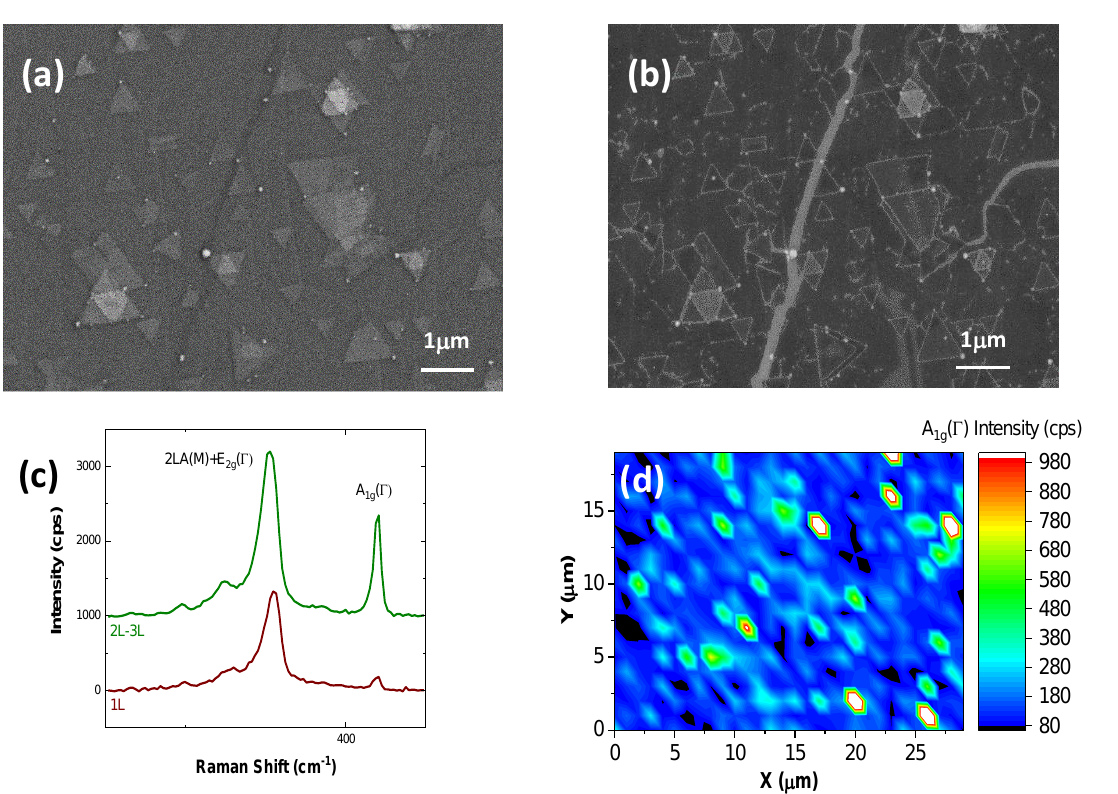
Figure 1. SEM (5 keV) image of a sample made of a WS 2 layer CVD-grown on epiGr/SiC, taken after 2 days of exposure to the ambient environment. ( a ) Image obtained from the SE2 detector; ( b ) image obtained from the SE1 detector. Bright dots and lines can be observed on the edges of the triangular WS 2 crystals. Long and irregular stripes can also be noticed in both images. ( c ) Characteristic µRaman spectra taken in different areas of the sample and ( d ) µRaman map of the A1g(Γ) mode intensity: the dark spots are due to the absence of WS 2 .